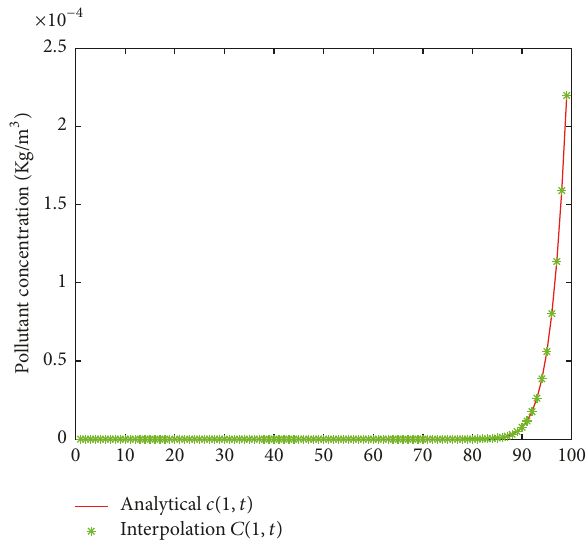
Figure 1: Comparison of analytical and interpolated left boundary conditions 𝑐(0, 𝑡) (kg/m 3 ) (Δ𝑥 = 0.0500 , Δ𝑡 = 0.0100 , Pe = 5.0) . Figure2:Comparisonofanalyticalandinterpolatedrightboundary conditions 𝑐(1, 𝑡) (kg/m 3 ) (Δ𝑥 = 0.0500 , Δ𝑡 = 0.0100 , Pe = 5.0) .